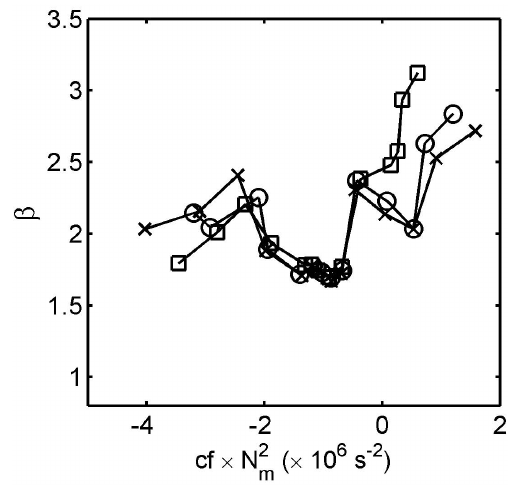
Fig. 14. Relationship between β (computed from horizontal q c field averaged over several vertical levels) and cf × N 2 m ( × 10 − 5 s − 2 ) . “x”, “o”, “ (cid:3) ” markers represent simulation times 05:00h, 04:00h and 03:00h,